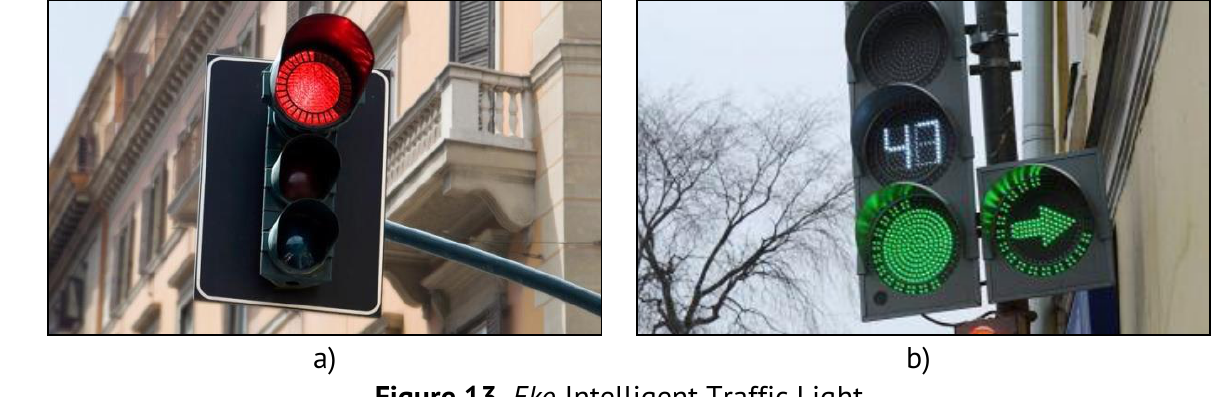
Figure 13. Eko Intelligent Traffic Light.